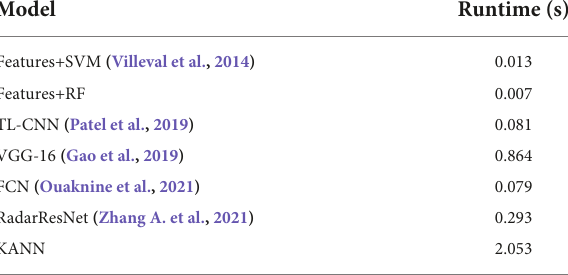
TABLE 4 Computational costs on different methods. Model